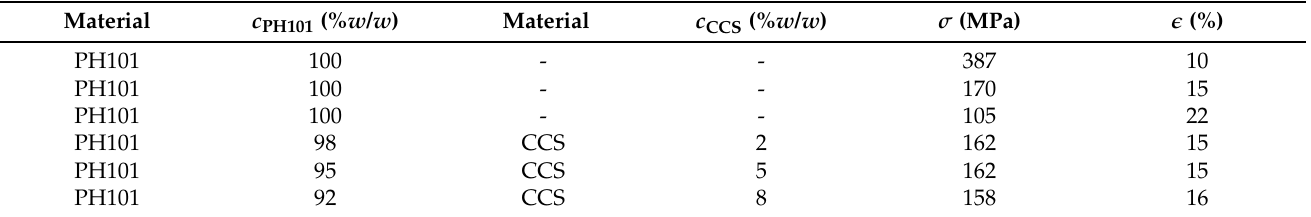
Table 3. Tablet formulations (PH101 concentration, c PH101 ; CCS concentration, c CCS ), compaction pressure ( σ ), and porosity ( (cid:101) ) investigated.